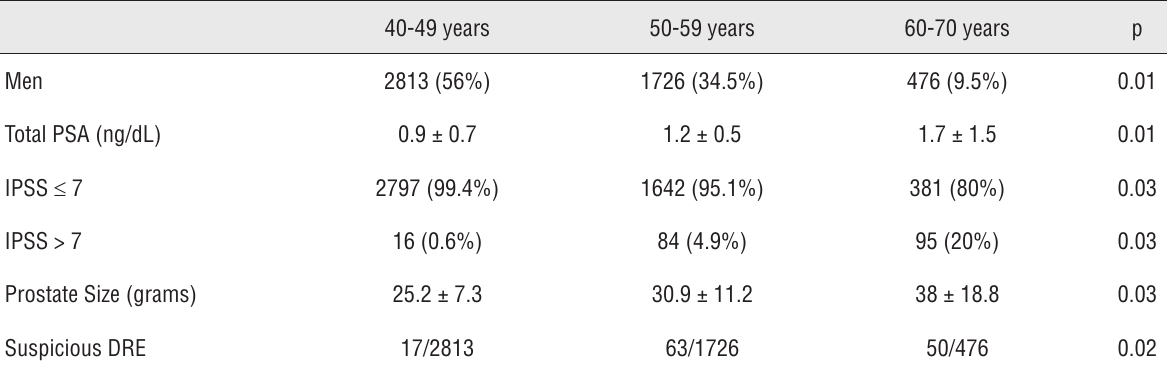
Table 2 - Averages of total PSA, IPSS and Prostate size of the 5015